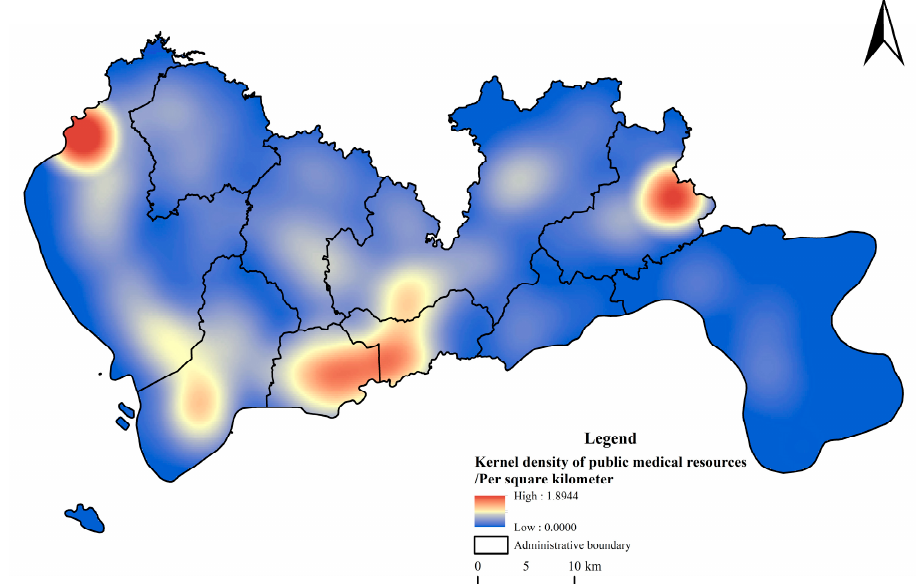
Figure 4. Estimated kernel density of public medical resources in Shenzhen in 2018.